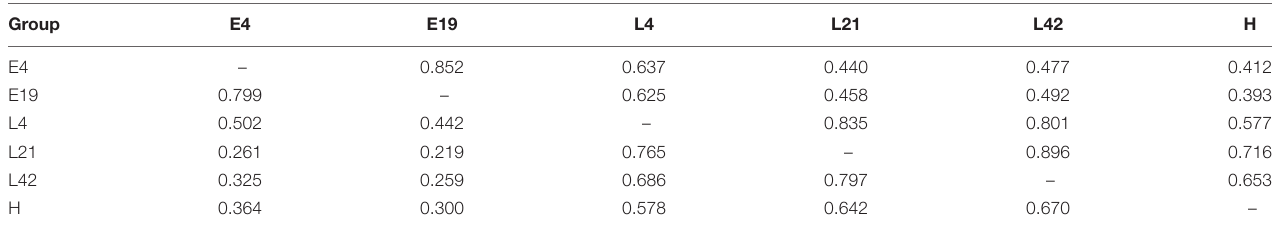
FIGURE 1 | Aggregate microbiota characteristics of 4-day (E4) and 19-day (E19) embryos. (A) Dominant taxonomic groups of embryos by phylum. (B) Microbial beta diversity of embryos with a Non-metric Multidimensional Scaling (NMDS) plot showing how distant E4 and E19 communities were. (C) Microbial alpha diversity with a box plot exhibiting the community diversity (The Shannon estimator). (D) Heatmap of hierarchy cluster results for the statistical significant microbial OTUs of two groups at the genus level. TABLE 1 | Gut microbial correlation coefficients at different host development